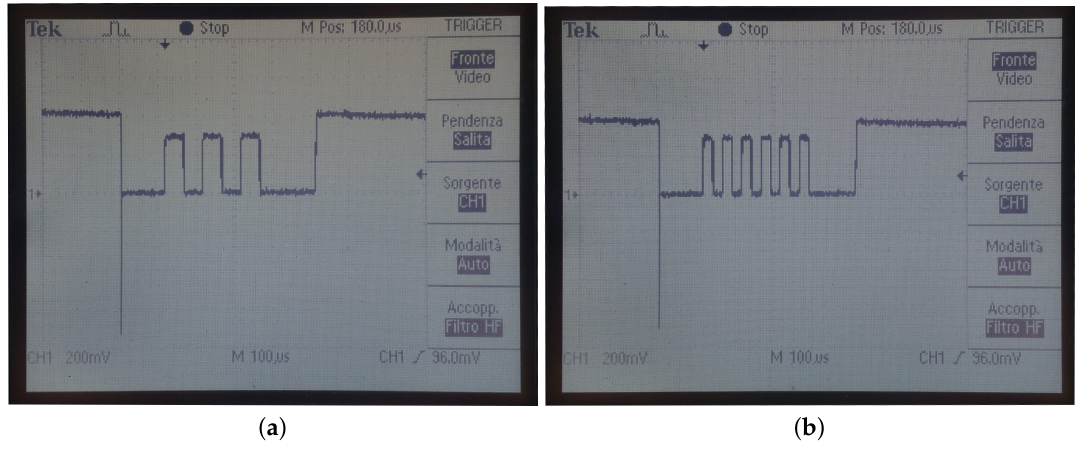
Figure 8. LED current: bit transmission. ( a ) ‘0’; ( b )